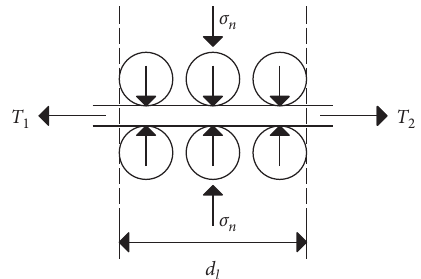
Figure 1: Principle of friction reinforcement.